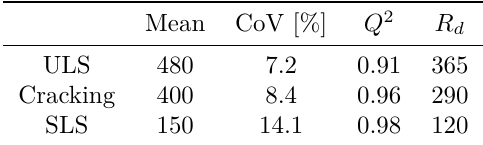
Tab. 1. Mean values and coefficients of variation were